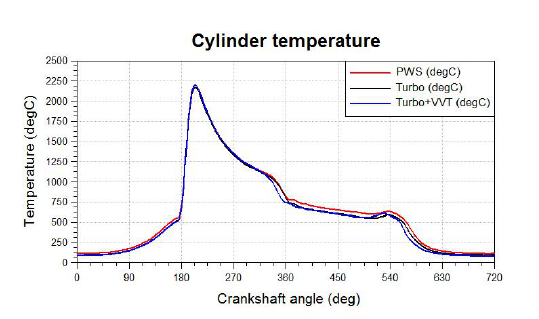
Figure 11. Cylinder temperature for the 3 setups.